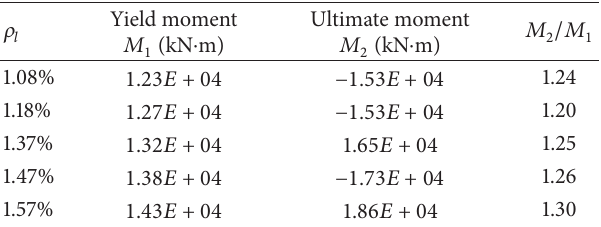
Figure 8: 𝑀 − 𝜑 curve of bottom section of PRC pier with different stirrups ratios. Table 3: Calculation results of PRC bridge piers with different longitudinal reinforcement ratios.